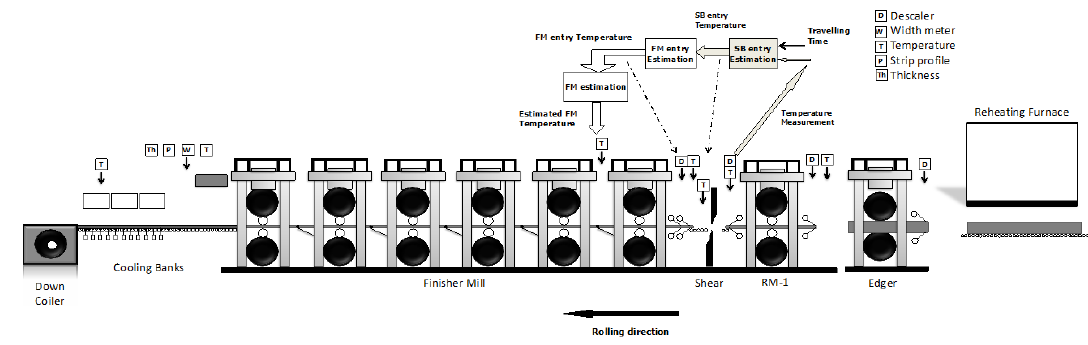
Figure 1. Hot-rolling mill production line with the temperature prediction block diagram.